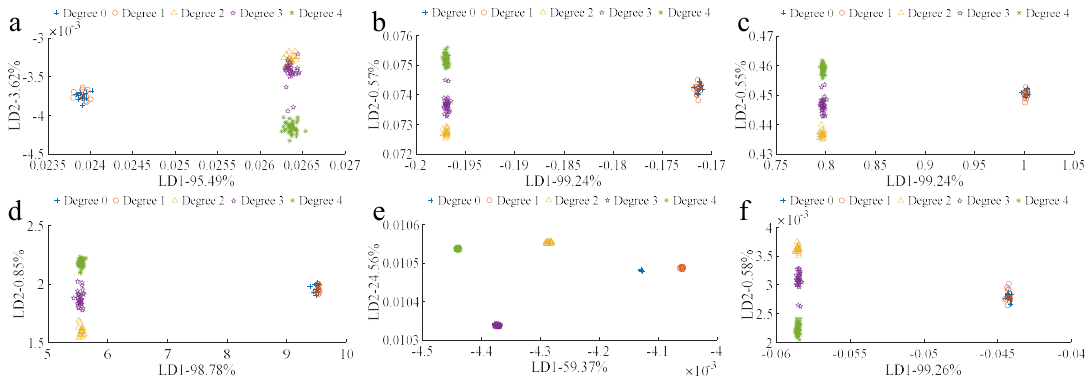
Figure 7. LDA granulation degree classification based on processing data using different methods:( a ) FD, ( b ) SR, ( c ) LM, ( d ) IM, ( e ) SG, and ( f ) MSC.